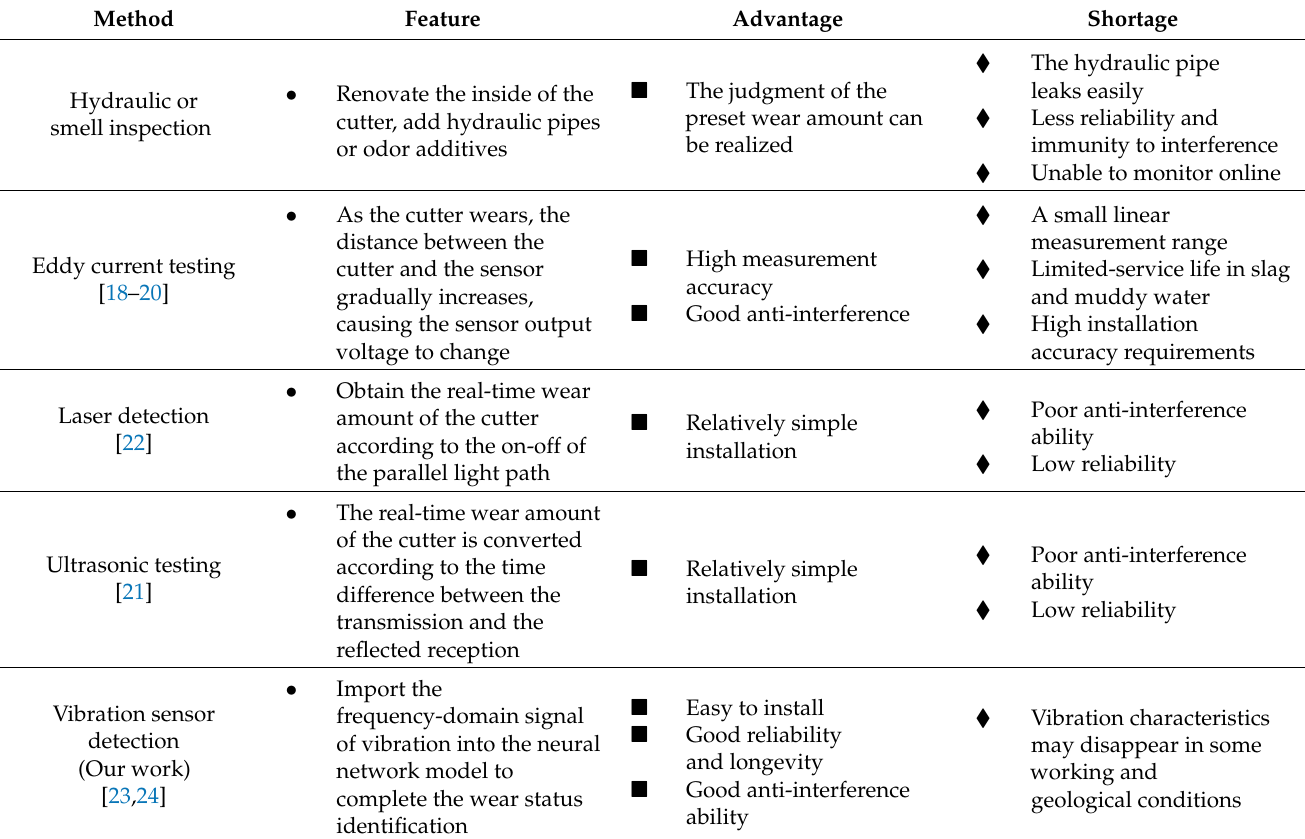
Table 1. Comparison between different wear identification